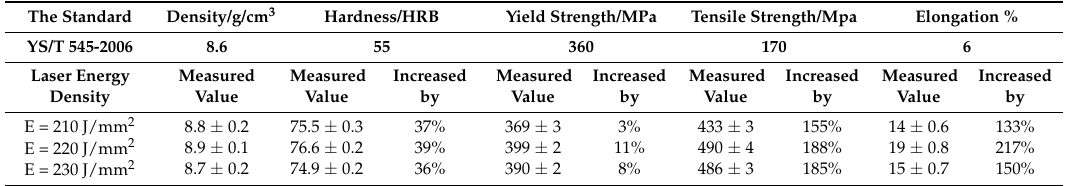
Table 2. Mechanical properties at different laser energy